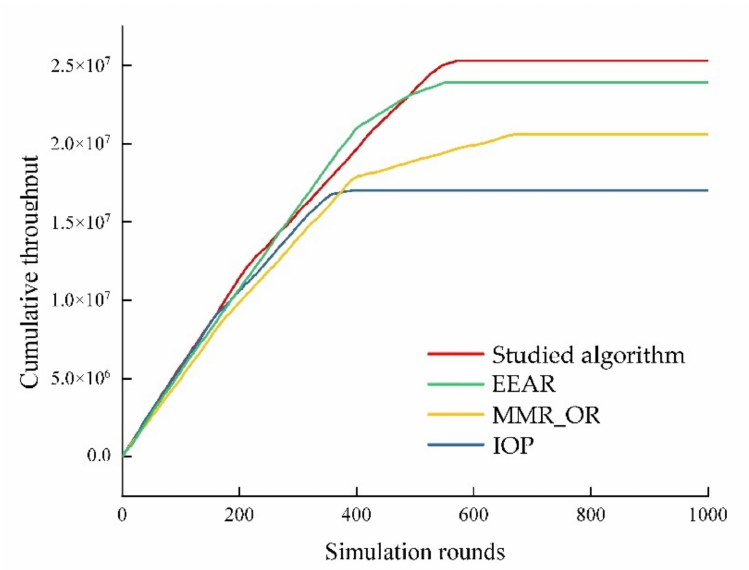
Figure 3. Comparison of death nodes.